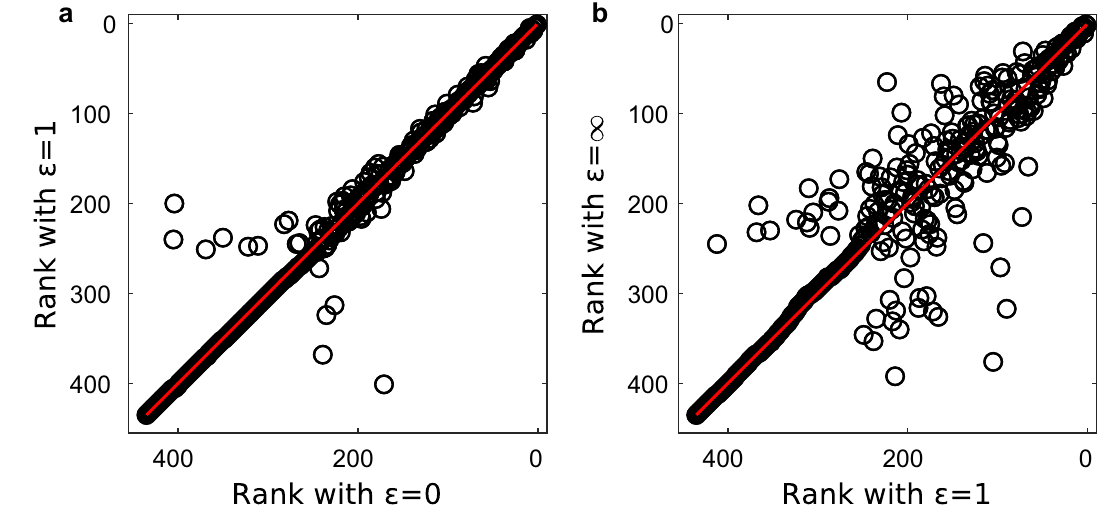
Figure 4. ( a ) Comparison between the rankings with ε = 0 and ε = 1 (for α = 12 / 13 ); ( b ) Comparison between the rankings with ε = 1 and ε = ∞ (for α = 12 / 13 ) Each dot represents an airport. The red line is the 1:1